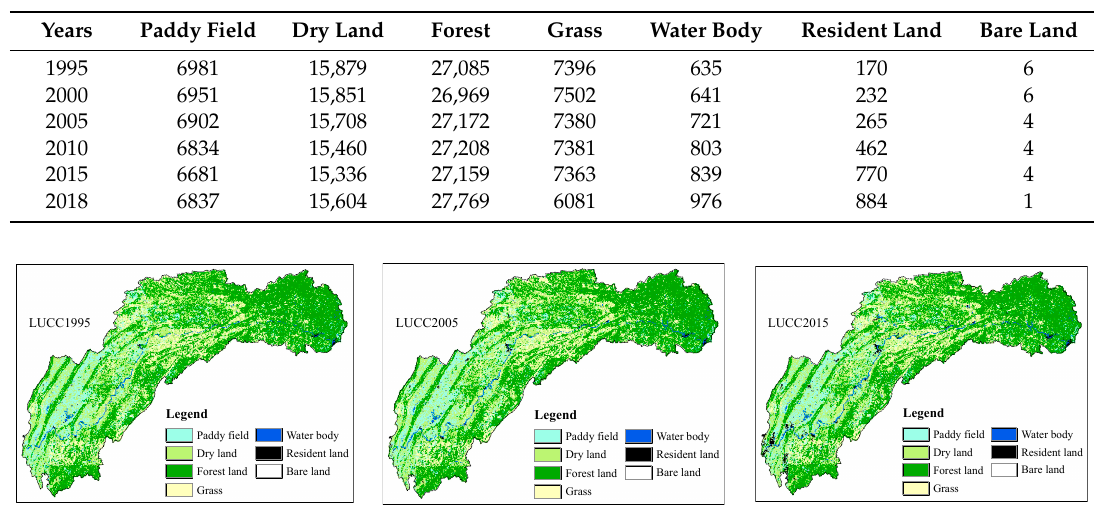
Table 2. Land use type statistics (unit: km 2 ).